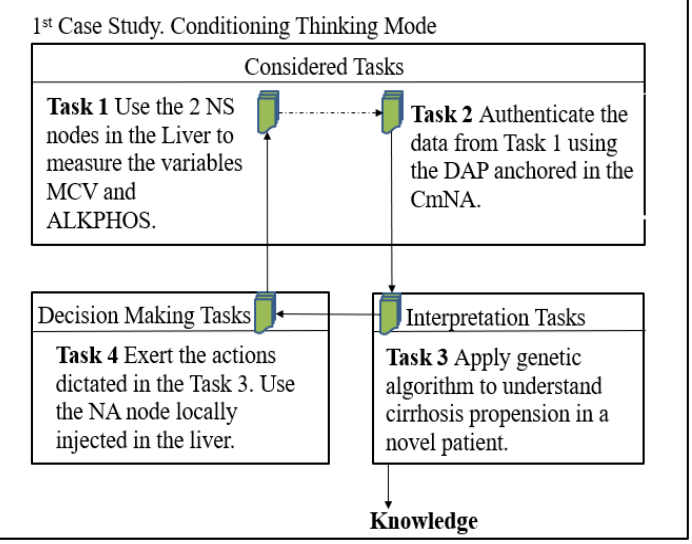
Figure 3. Instantiation of the CTM AC to the 1st Case Study.